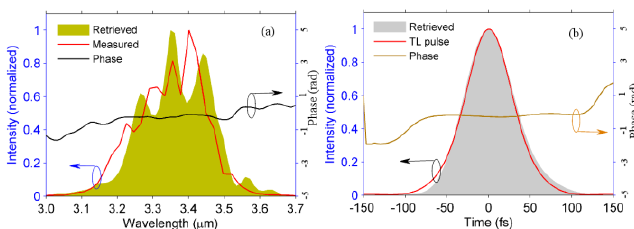
Fig. 3. Spectral phase (a) and pulse envelope (b) characterized by